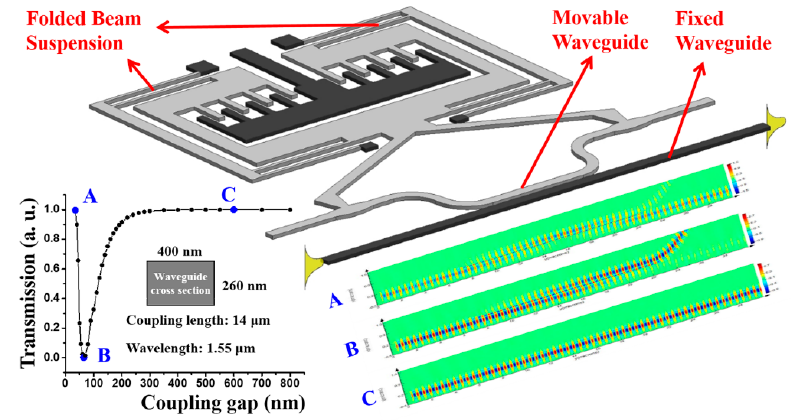
Figure 3. Schematic of the tunable waveguide coupler controlled by a comb drive actuator. FDTD simulated results of optical transmission and selected mode profiles are shown at left and right bottom.